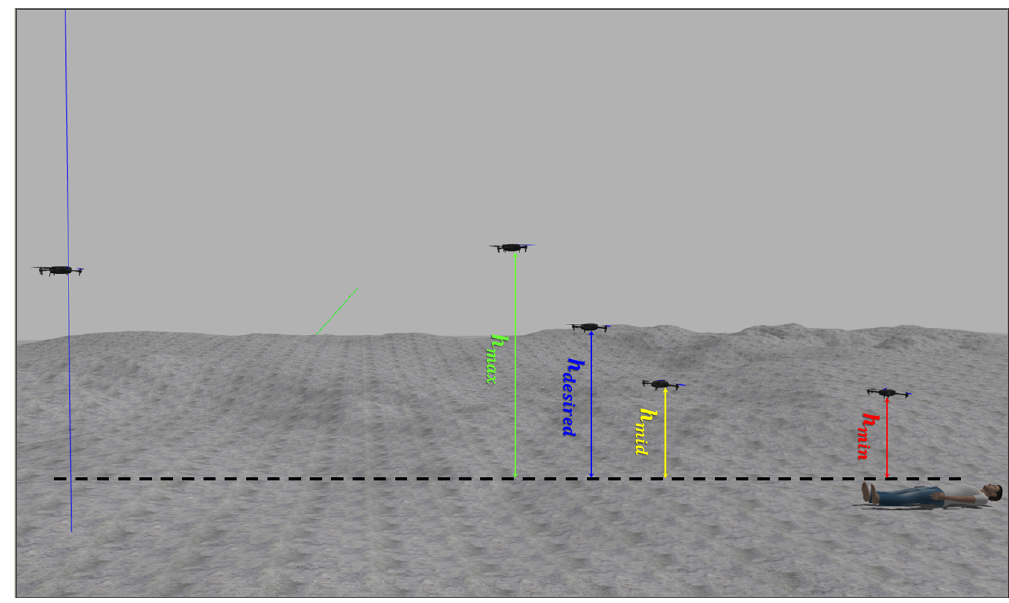
Figure 11. Reference velocity with respect to the distance.